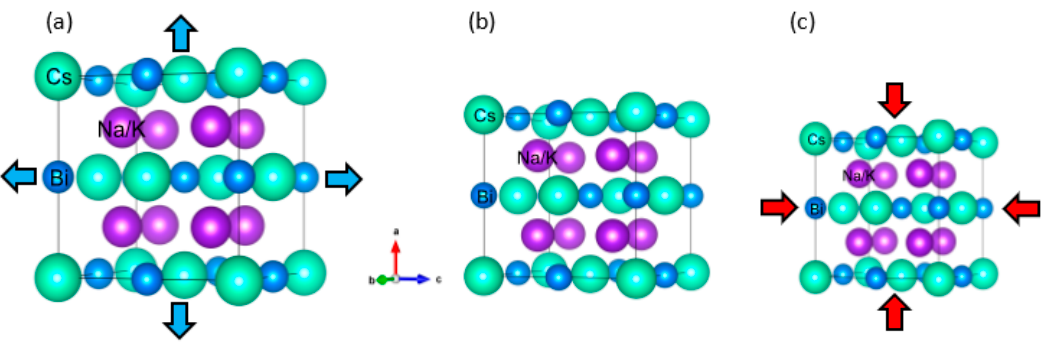
Figure 1. The crystal structures of Cs(Na, K) 2 Bi compounds ( a ) under hydrostatic tension, ( b ) equilibrium states, and ( c ) hydrostatic compression. The Cs atoms are sited at 4a (0, 0, 0) Wyckoff position, Na/K atoms are sited at 8c (0.25, 0.25, 0.25) and (0.25, 0.25, 0.25) Wyckoff positions, and Bi atoms are sited at 4b (0.5, 0.0, 0.0) leading to a primitive cell involving four formula units, namely two K/Na atoms and two Bi and Cs atoms.